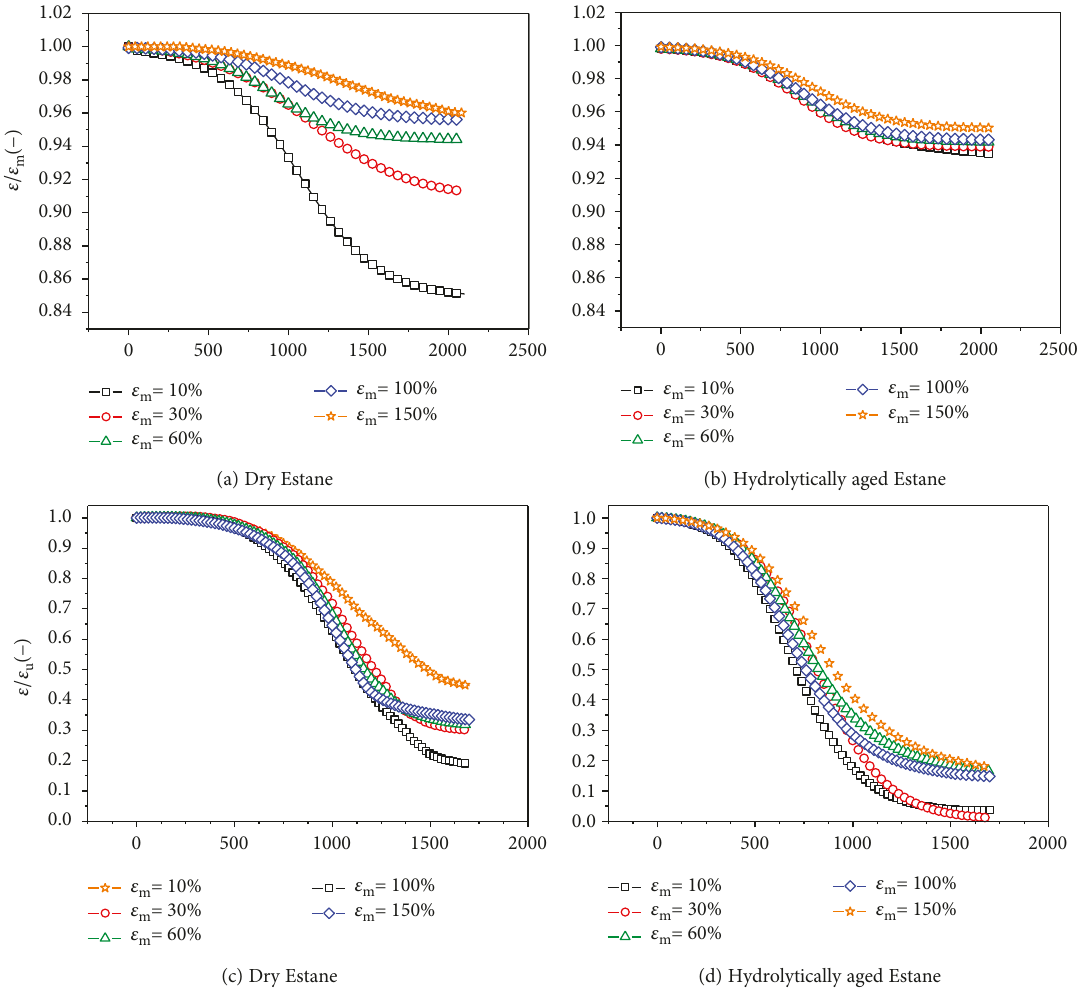
Figure 11: Development of reduced strain values ( ε / ε unloading process in the 2nd cycle stretched up to di ff erent maximum strains ε thermomechanical tensile test. Development of reduced extension values ( ε / ε samples during the recovery process in the 2nd cycle stretched up to di ff erent maximum strains ε a cyclic thermomechanical tensile